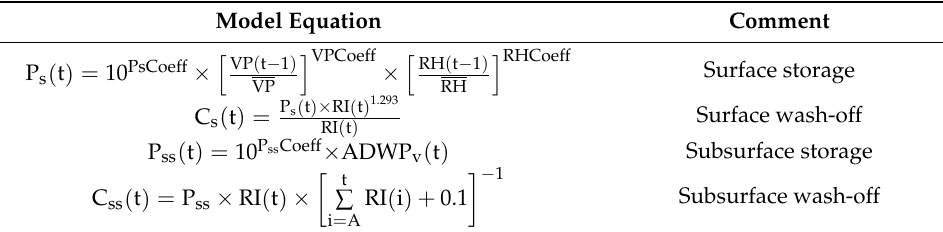
Table 1. The governing equations of the microorganism model in